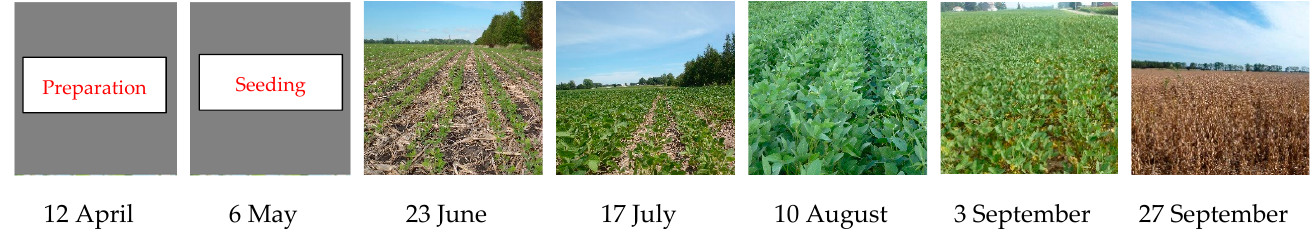
Figure 2. Field photos of three main crop types over the study site on selected acquisition dates. Top row, winter wheat; middle row, corn; bottom row, soybean. The grey boxes correspond to no photos taken due to crop fields in preparation, seeding or harvested time.